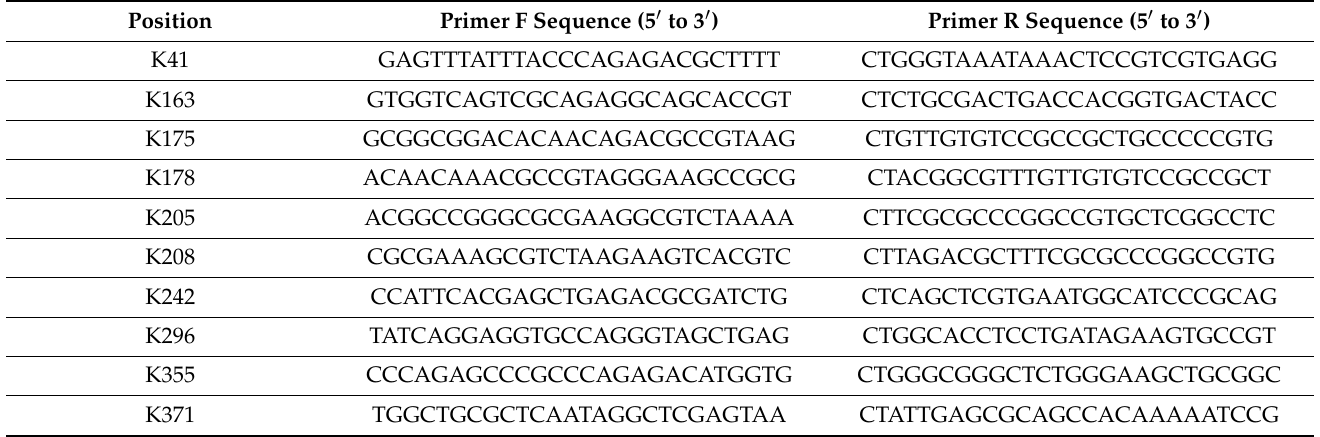
Table 1. Primers used to individually mutate all ten lysine residues of UL80.5 to